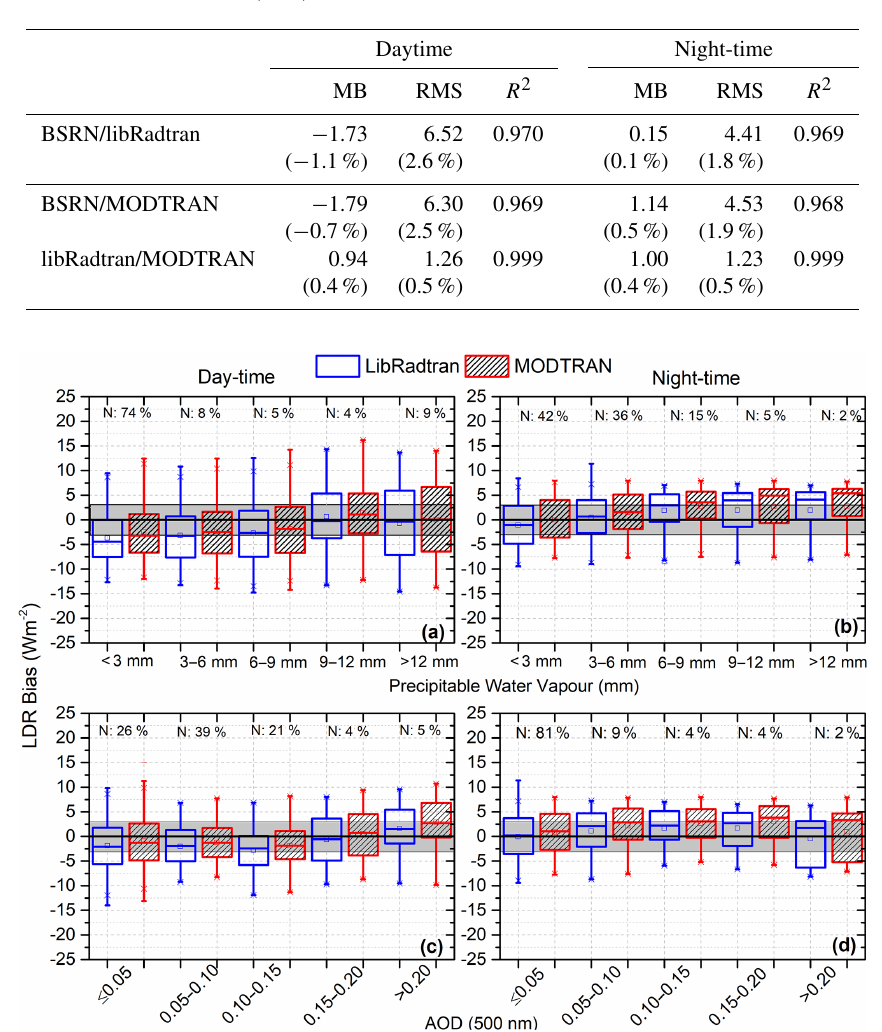
Figure 4. Box plot of mean LDR bias (model–BSRN in Wm − 2 ) vs. PWV (mm) (a) at daytime (b) at night-time, and vs. AOD (500nm) (c) at daytime and (d) at night-time between 2010 and 2016. Lower and upper boundaries for each box are the 25th and 75th percentiles; the solid line is the median value; the crosses indicate values out of the 1.5-fold box area (outliers); and hyphens are the maximum and minimum values. The blue boxes represent libRadtran/BSRN and the red ones represent MODTRAN/BSRN. N indicates the number the measurements in each interval. Shadings show the range of instrumental error ( ± 3Wm − 2